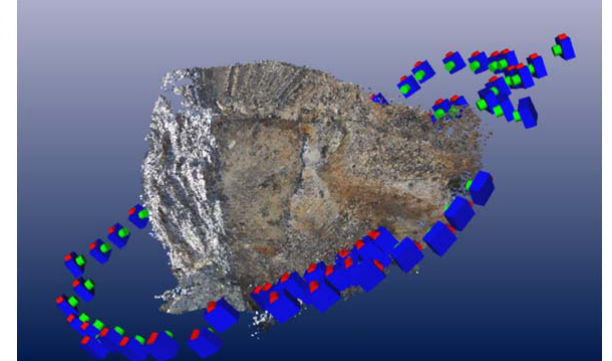
Figure 15: Example of the Point Cloud, Together with Camera Positions